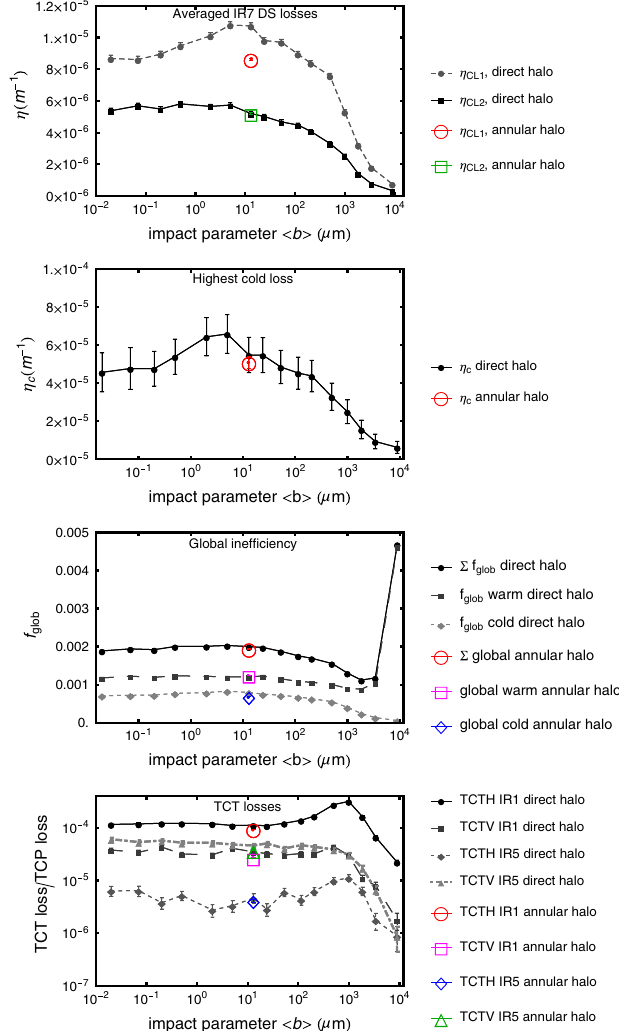
FIG. 10. The dependence of various losses on the TCP impact parameter b , as simulated with SixTrack. All simulations were carried out for a horizontal halo in B1.